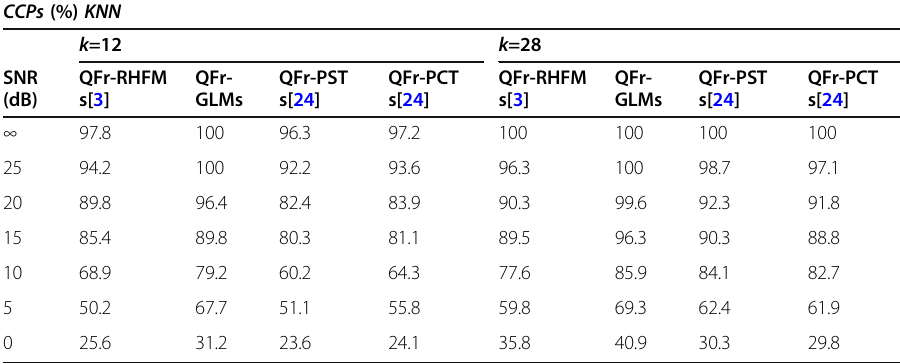
Table 6 Geometric invariant classification comparative study of the QFr-RHFMs, QFr-GLMs, QFr- PSTs, and QFr-PCTs